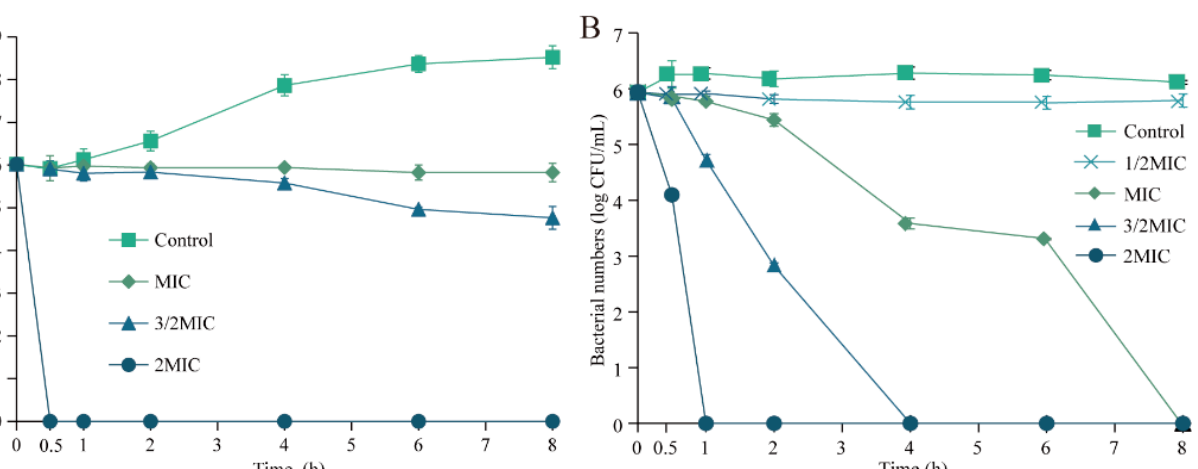
Figure 2. Growth curve analysis of Sh. flexneri with various concentrations of eugenol. 3.3. Inactivation Effect of Eugenol on Sh. flexneri in LB and PBS